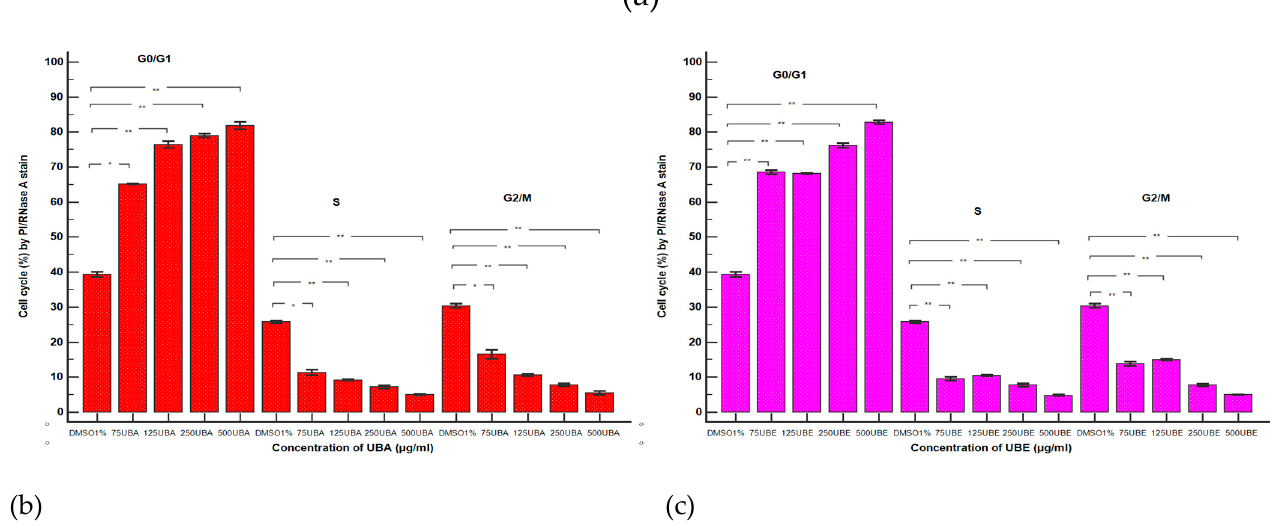
Figure 12. Statistical analysis of DNA content: ( a ) UA; ( b ) UBA; ( c ) UBE. * p < 0.01, and ** p < 0.001 represent significant statistical differences between control and samples made by paired samples t -test.